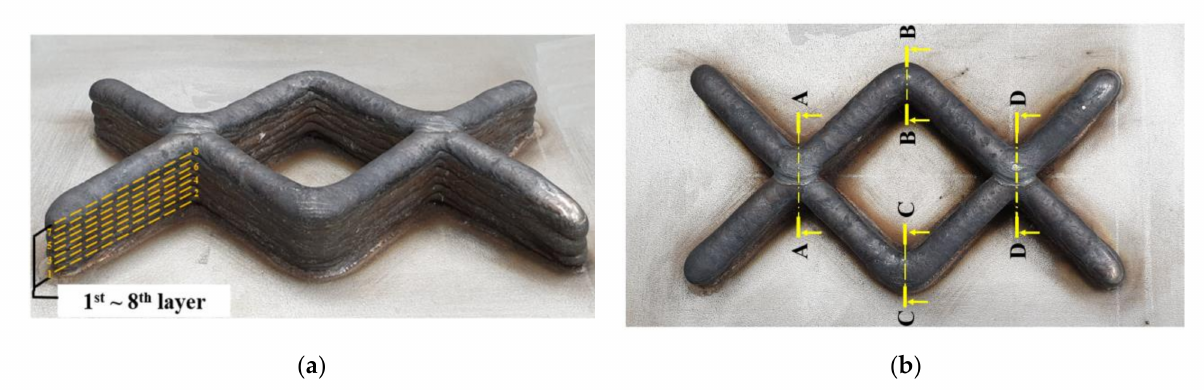
Figure 10. The results of multi-layer experiments: ( a ) the product of multi-layer experiments, ( b ) the height measured sections of